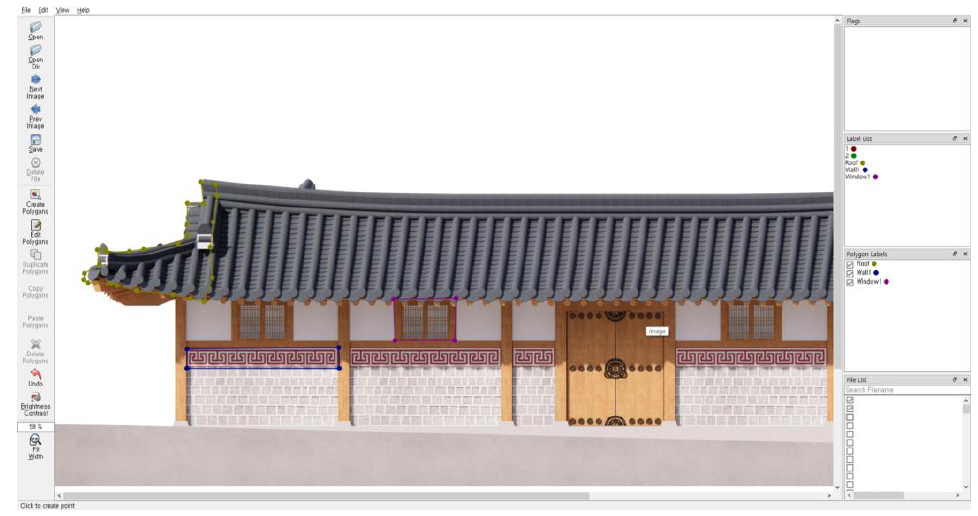
Figure 14. Example of labeling using Labelme.